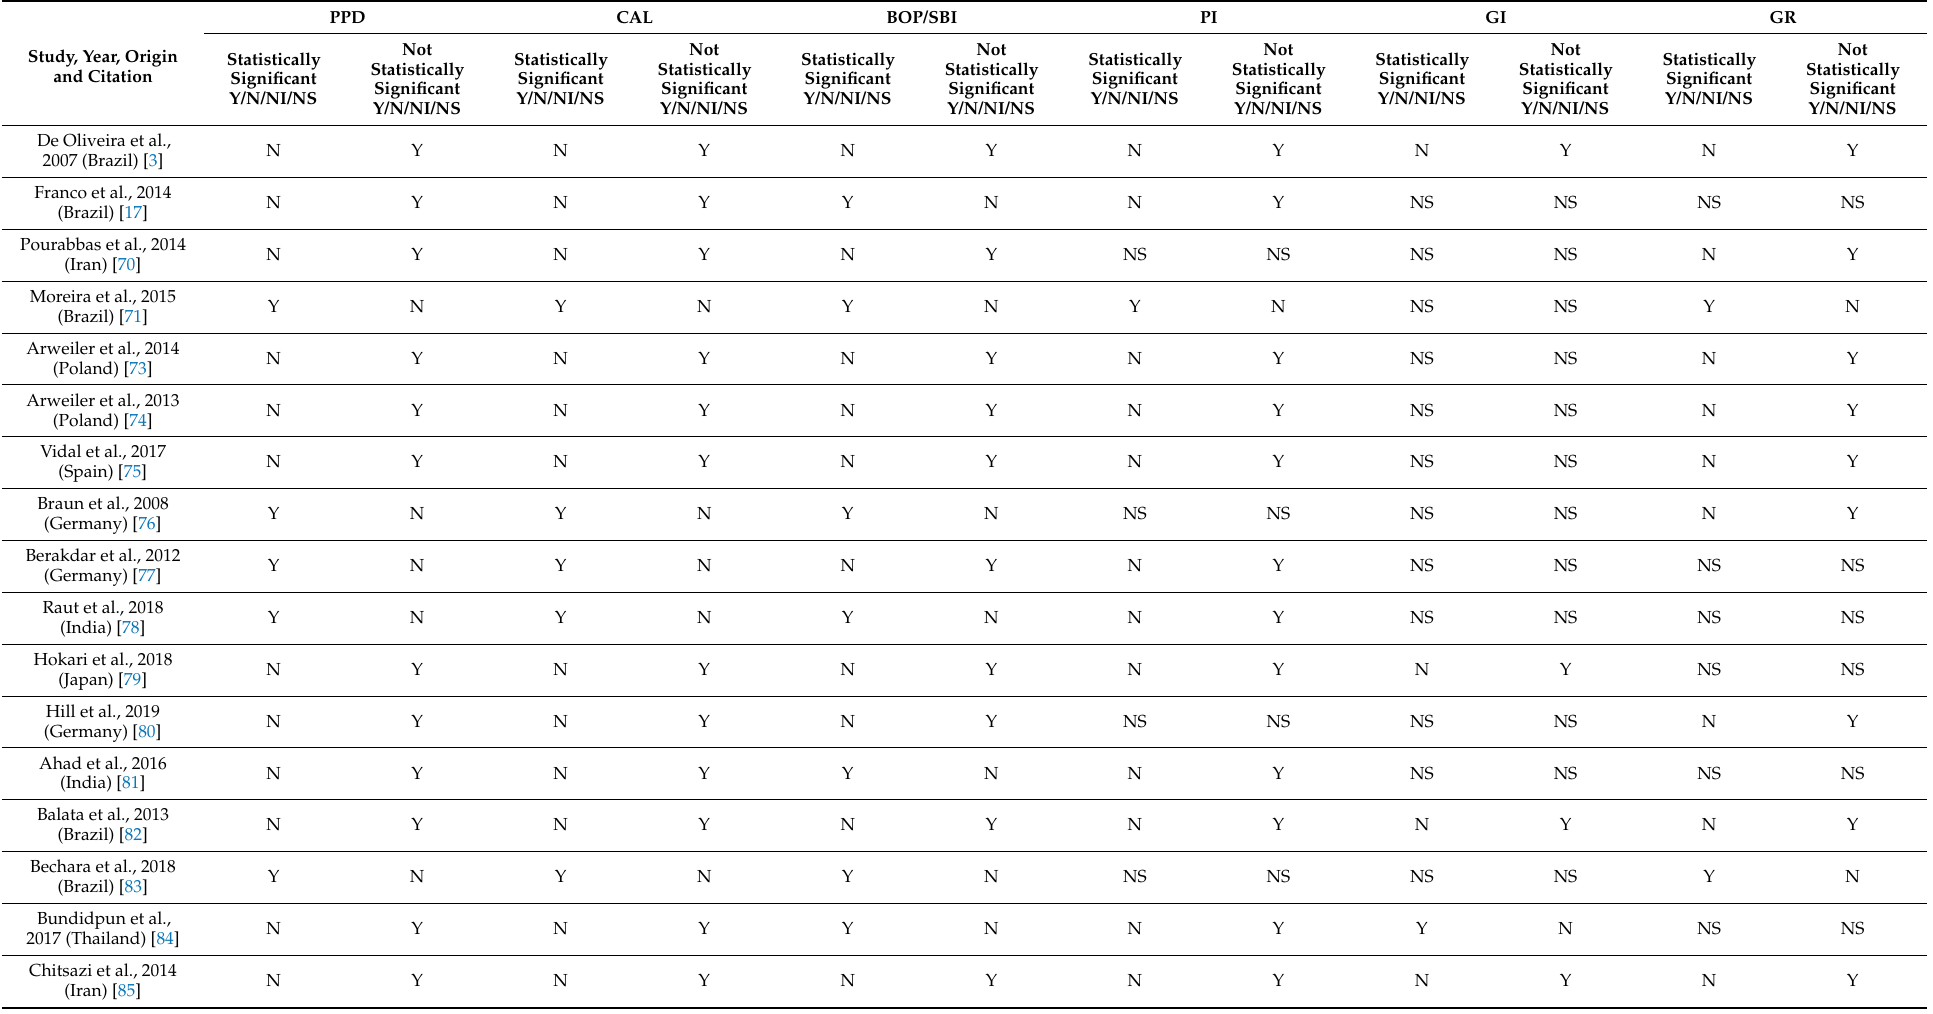
Table 5. Tabular representation describing the assessment of clinical parameters used for the selected eligible in vivo human studies. Refer to Supplementary file 2 for a list of